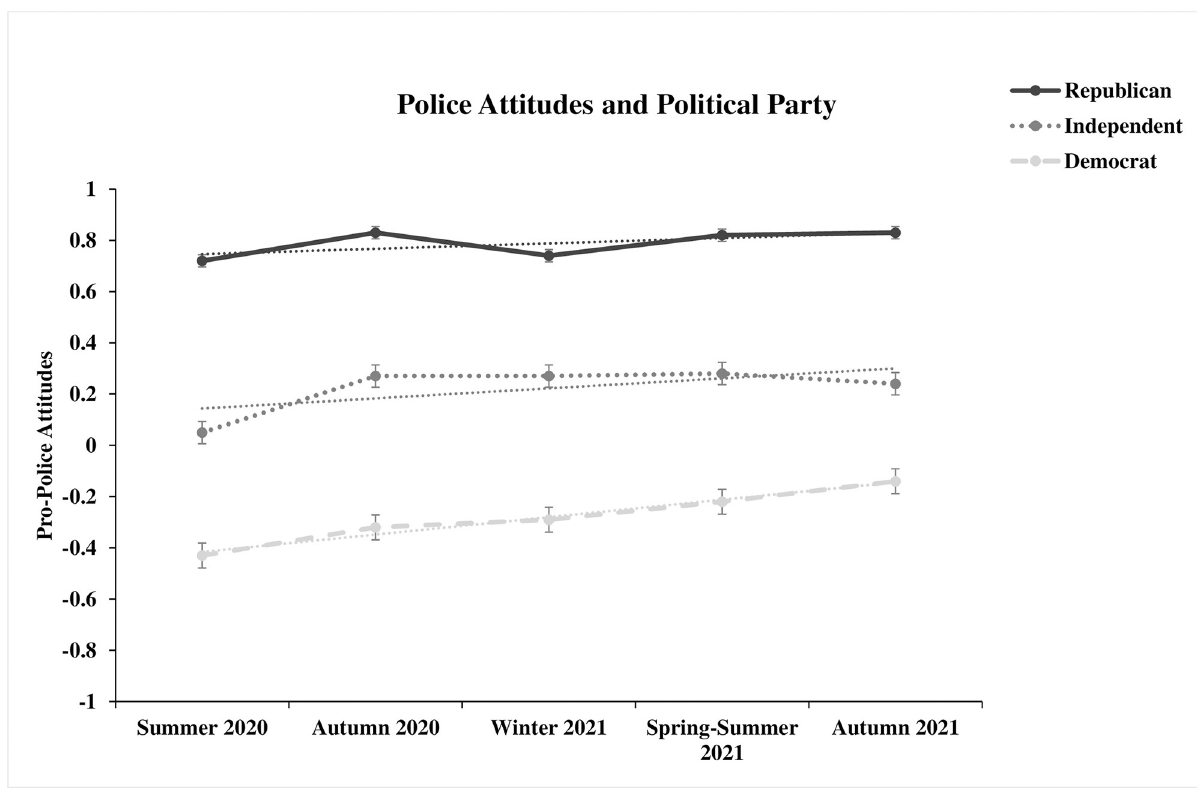
Fig 4. Pro-police attitudes are factor scores derived from the 5-factor confirmatory factor analysis model with items administered at a given time point loading solely on a single-factor at that timepoint. Number of participants across time points ranged from 411 to 448 for Democrats, 236 to 259 for Republicans, and 281 to 301 for independents or unaffiliated